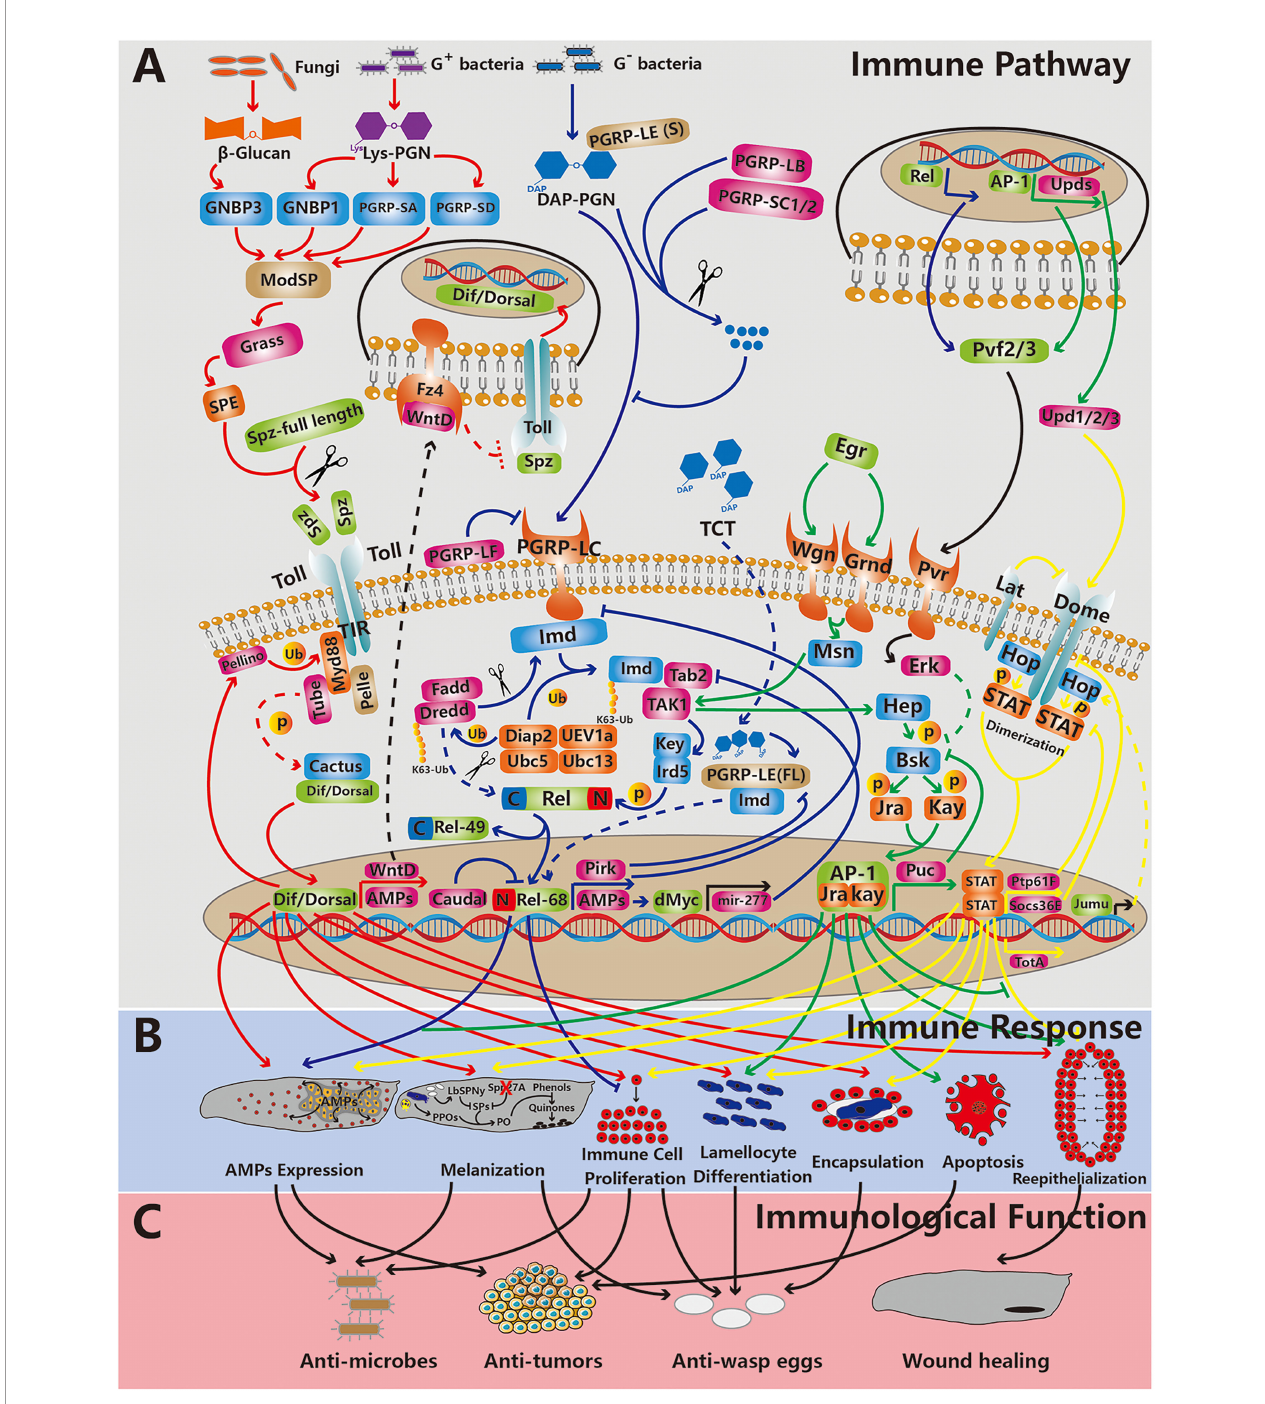
FIGURE 2 | The relationship between main immune pathways, immune responses and immunological functions in Drosophila innate immunity. From top to bottom, the three rows represent the immune pathway (the Toll, Imd, JNK and JAK/STAT pathways are depicted,from left to right) (A) , the immune response (B) and immunological functions (C) . The red, blue, green and yellow lines indicate that the processes are related to the Toll, Imd, JNK and JAK/STAT pathways, respectively. The black lines indicate that the processes are related to other pathways. The dotted lines represent processes waiting to be con fi rmed. The arrows and “ T ” indicate promoting and inhibitory effects, respectively. The red cross indicates depletion. The scissors represent cleavage. Abbreviation: p, phosphorylation; Ub, ubiquitination; (s), short form; and (f), full